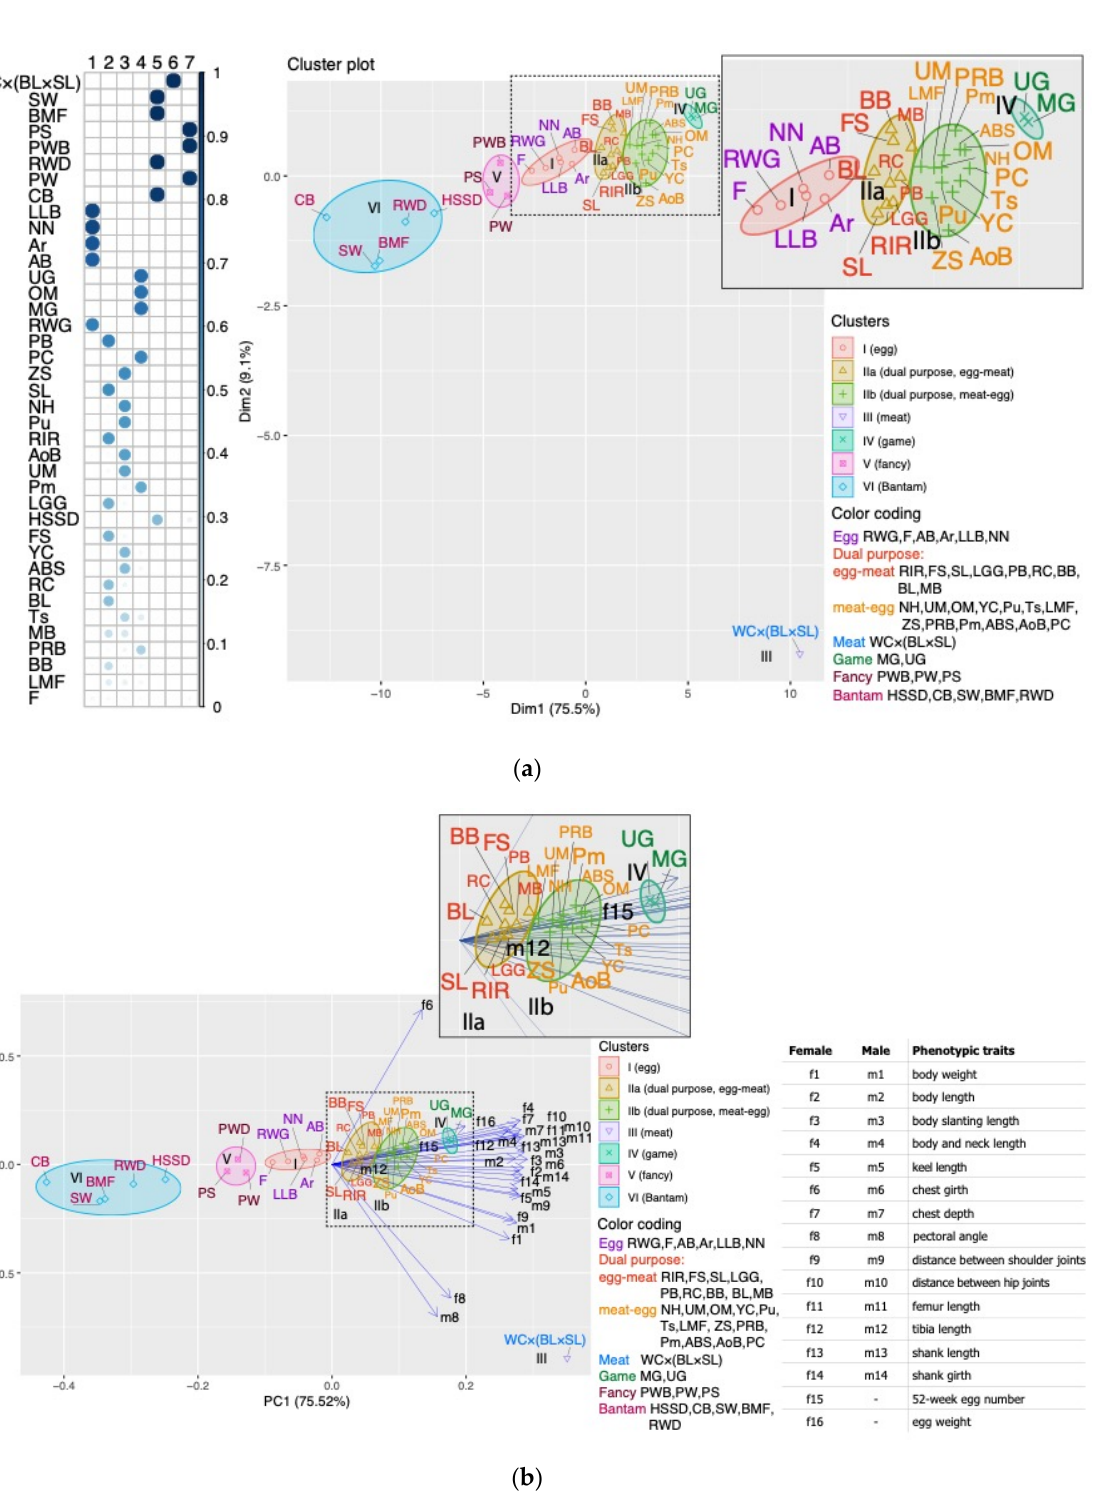
Figure 1. Clustering patterns for the 39 chicken breeds/populations based on their phenotypic traits and using fuzzy analysis clustering ( a ) and PCA ( b ). The observed clustering pattern of six clusters formed the basis of PCM. Population codes are given according to Supplementary Table S1.